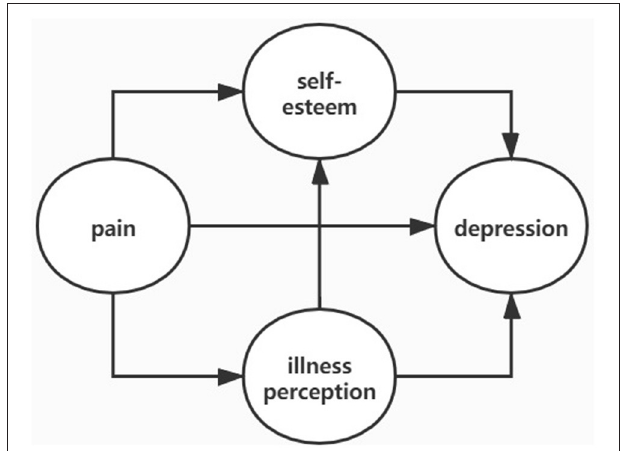
FIGURE 1 | Theoretical framework for the development of depression in CKD